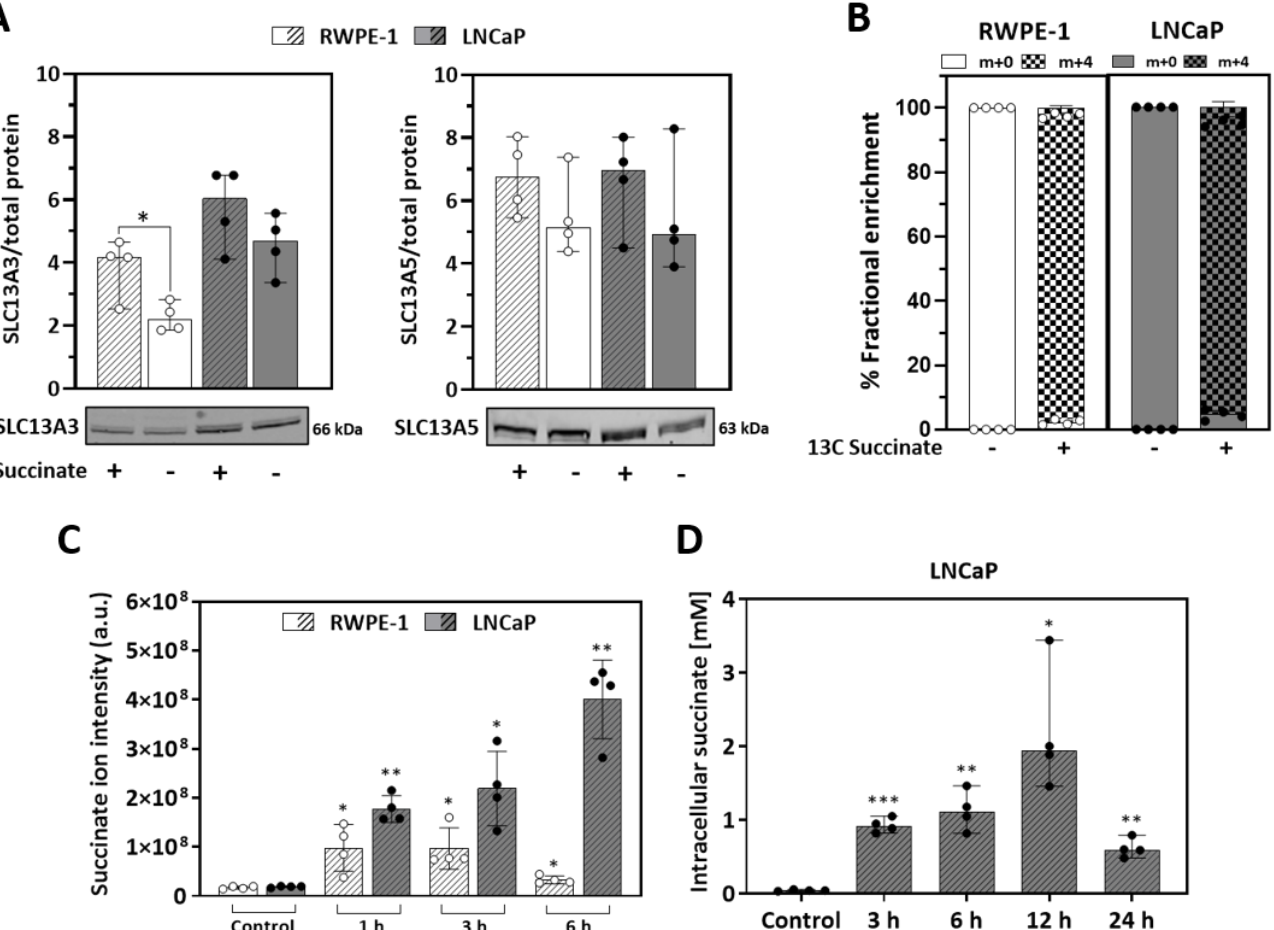
Figure 1. Succinate transport and accumulation. Expression of dicarboxylate transporters and succinate uptake in RWPE-1 and LNCaP cells incubated for 6 h ( A – C ) or up to 24 h ( D ) with 5 mM succinate or vehicle as controls. ( A ) SLC13A3 (NaDC3) and SLC13A5 (NaCT) expression. Left, representative western blot image; right, quantification of protein band intensities relative to total protein content within each extract of RWPE-1 and LNCaP cells ( N = 4). ( B ) Succinate uptake (% of total fractional enrichment) analyzed by target metabolomics. Cells were incubated for 6 h with 5 mM succinic acid- 13 C 4 or the same volume of vehicle as control ( N = 1; n = 4) ( C ) Transient intracellular succinate accumulation measured by untargeted LC-MS as succinate ion intensity ( N ≥ 2; n = 4). ( D ) Intracellular succinate concentration [mM] in LNCaP cells. ( N = 1; n = 4). Median and IQR. Unpaired t -tests comparing +/- succinate in each condition ( A , B ) one or two-way ANOVA and Tukey’s multiple comparisons tests ( C , D ). * p = 0.05; ** p < 0.001; *** p <